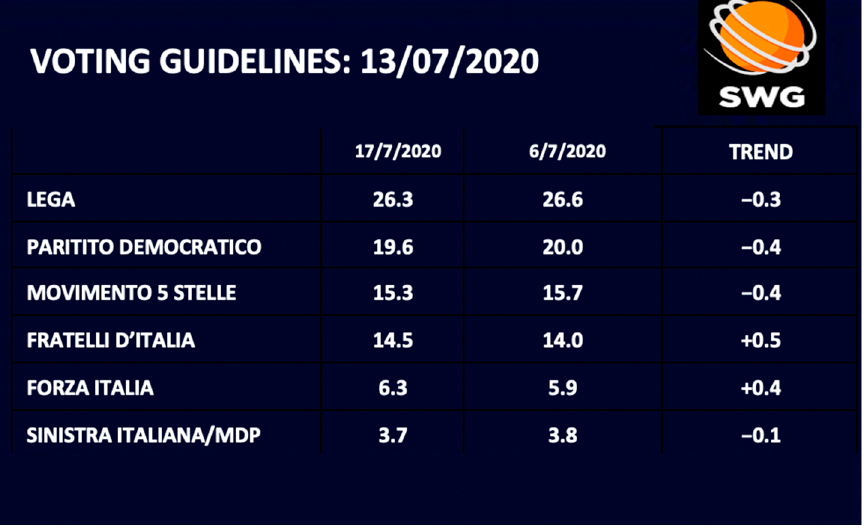
Figure 4. Polls retrieved by Swg, June 2021. February, however, can be considered a turning point. SWG released the results of the Italians’ voting orientation and to no little surprise Fratelli d’Italia breaks the 17% consensus wall, a figure that for the first time leads analysts and commentators to speak of a possible overtaking of Meloni’s party against the Partito Democratico (Figure 5).